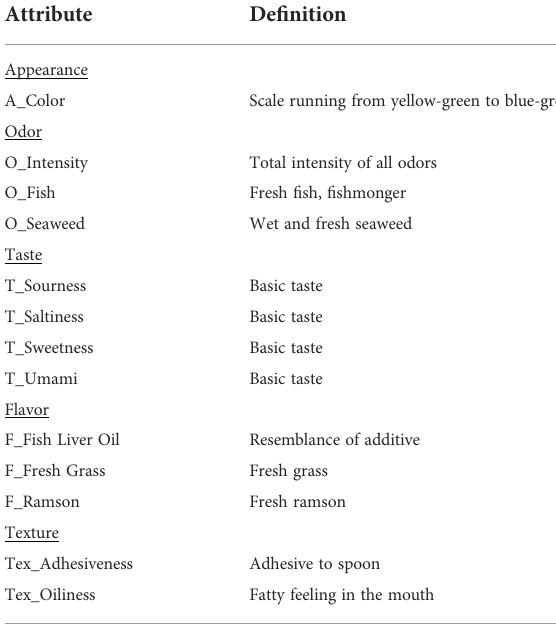
TABLE 2 Sensory attributes and their de fi